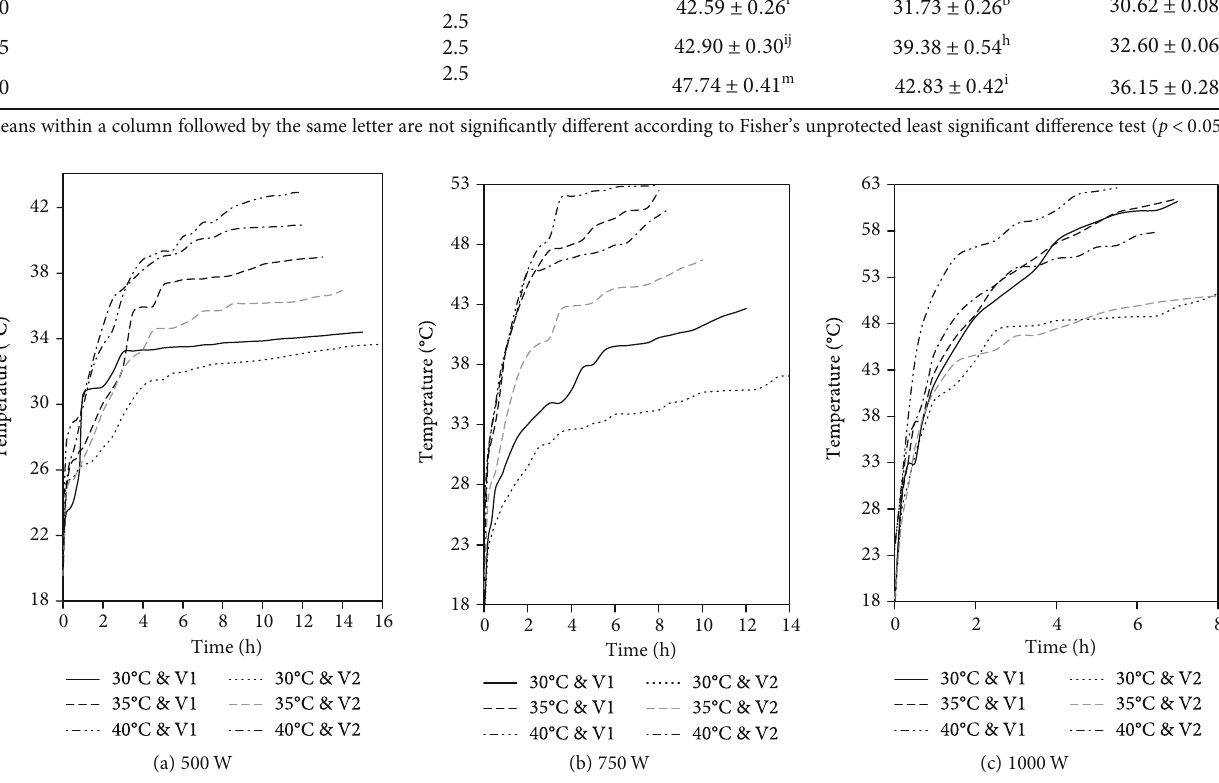
Figure 2: Variation in core temperature of the beef sample during drying at selected IR emitter power temperature and air velocity of the drying air ( V1 = 1 : 5 m ∙ s − 1 and V2 = 2 : 5 m ∙ s − 1